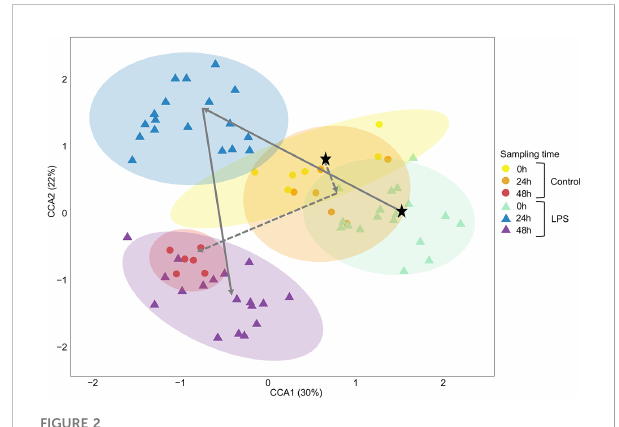
FIGURE 2 Canonical correspondence analysis (CCA) ordination plot of the relationships between the bat gut bacterial community composition, sampling time (0h, 24h, 48h) and treatment group (control vs . LPS). The CCA revealed that the gut bacterial community composition of bats clustered by sampling time at time points 0h (yellow and green) and 48h (red and purple) and by treatment at time 24h (orange and blue). The fi rst and second canonical correspondence axes are shown. Values in brackets represent the percentage of total variance explained by the axis. Each dot represents a sample ( i.e. , of an individual at a time point). The average direction of the temporal shift in the bacterial community composition is marked by dashed (control) or full (LPS) arrows with a black star depicting the starting point. LPS, lipopolysaccharides.